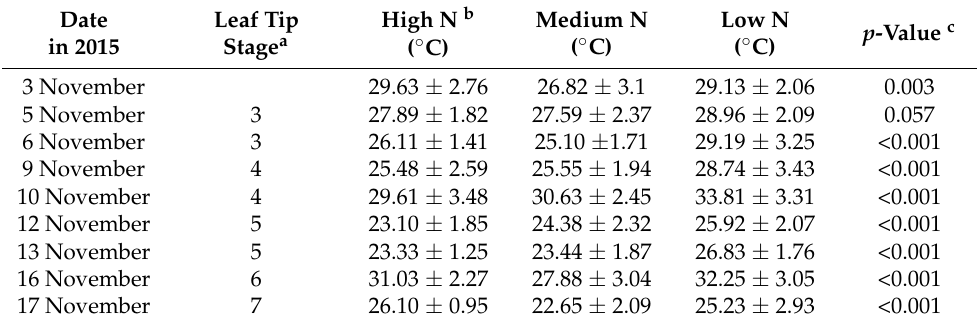
Table 4. The mean leaf temperature increases with nitrogen stress in the first experiment, using IR handheld gun